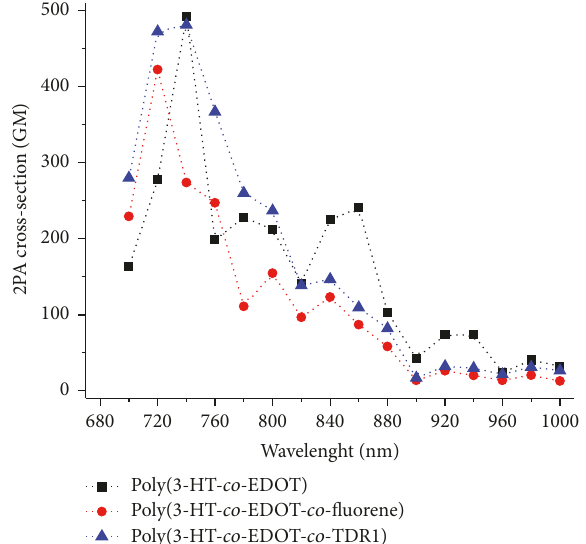
Figure 6: 2PA cross-section of the polymers. The dotted lines are guides for the